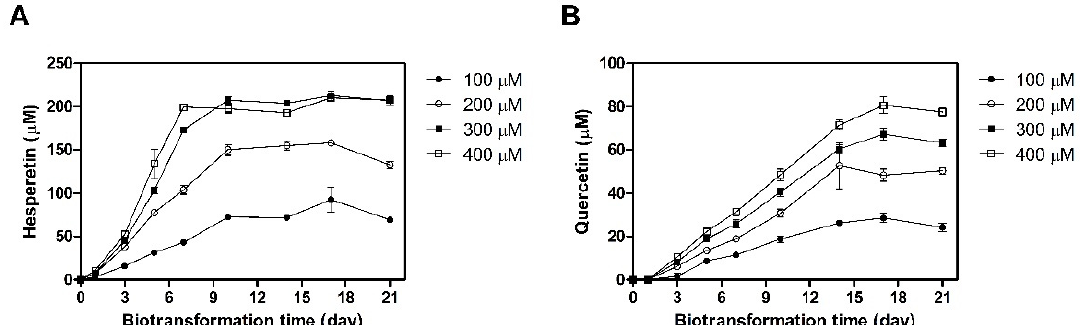
Figure 3. Production of hesperetin ( A ) and quercetin ( B ) by L. pentosus NGI01.